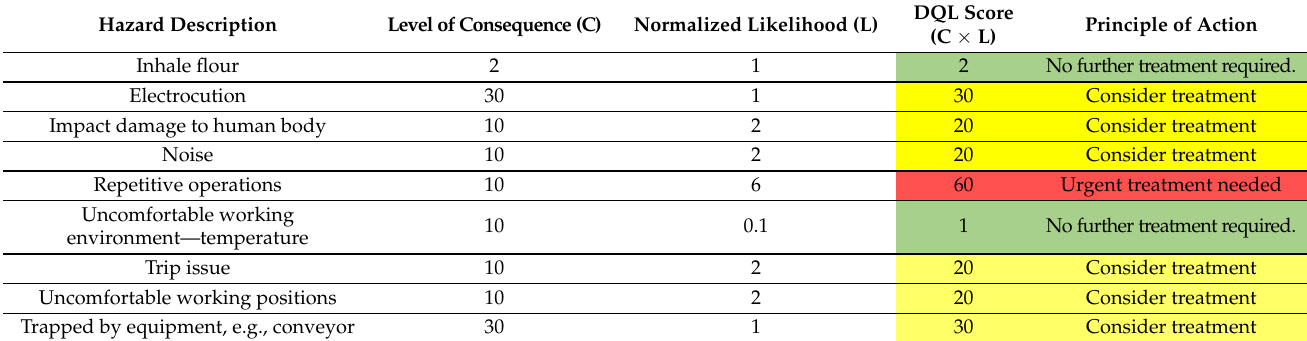
Table 5. Harmonizing risk assessment result for case